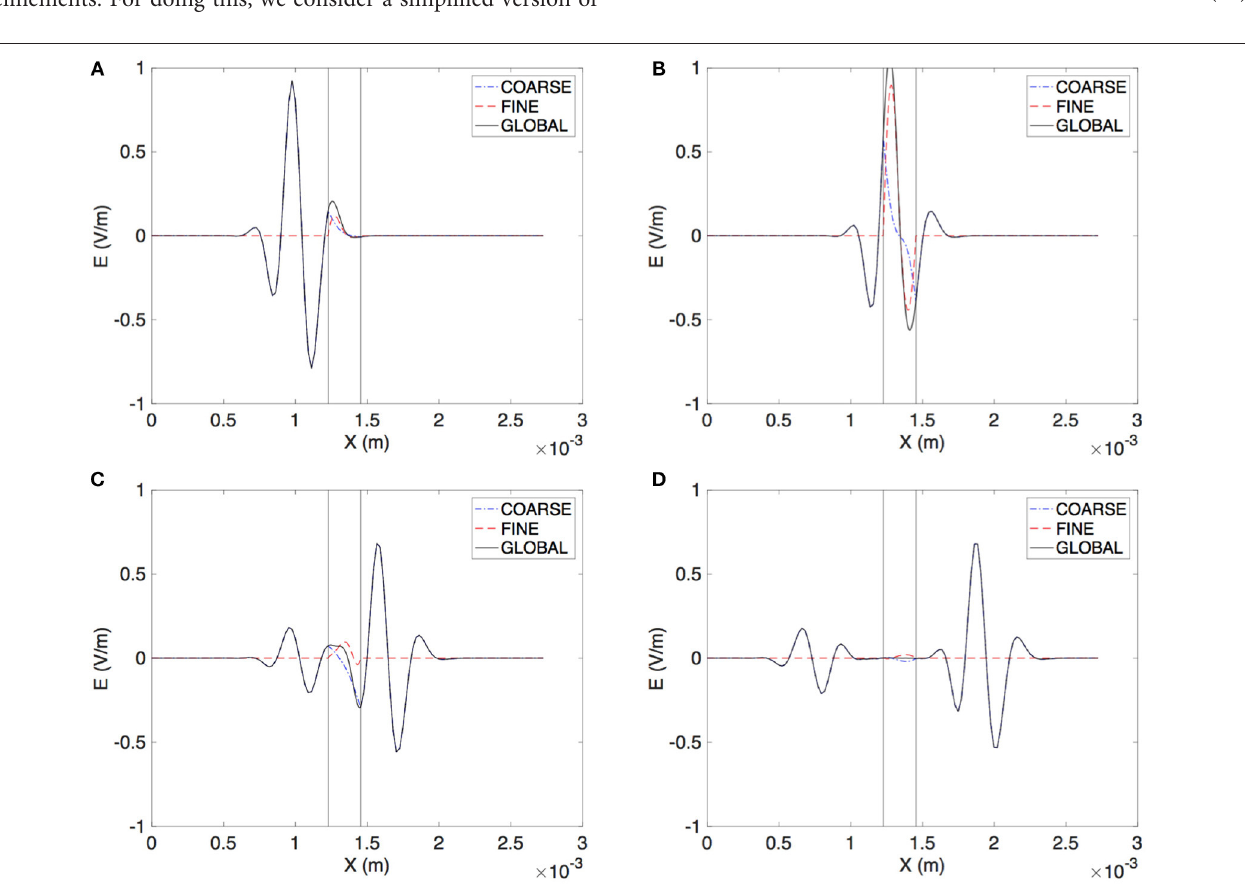
FIGURE 3 | Time evolution of the electric field concerning the 1D propagation of a modulated Gaussian pulse through a static plasma [particularly, the field at different times from (A)–(D) ]. The Gaussian pulse width is large enough to see about 3 cycles of modulation. The plasma density is a Gaussian with maximum 10 22 m − 3 (with standard deviation of 10 − 5 m) in the center of patch identified by two vertical lines in the figures. The patch is about 13 times smaller than the coarse domain and the refinement ratio between coarse and fine grids is equal to H / h = 10, with h and H being the spatial fine and coarse steps, respectively. The global solution of the electric field is represented with a black solid line, the solutions calculated on the coarse and fine grids are in blue dash-dotted and red dashed lines, respectively.